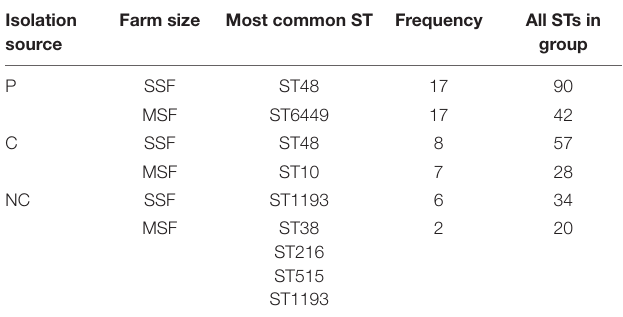
TABLE 3 | Distribution of MLST sequence types amongst sample groups. Isolation